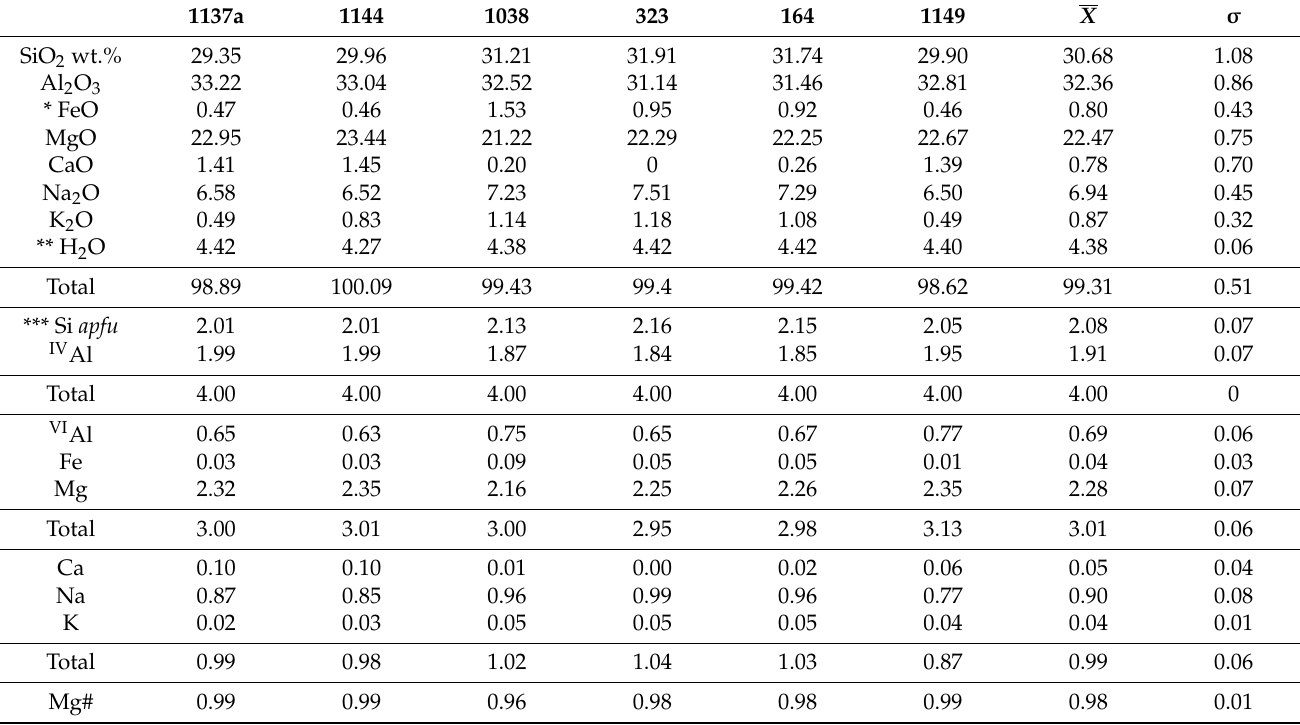
Table 1. Results of electron-microprobe analyses of preiswerkite from the Luc Yen